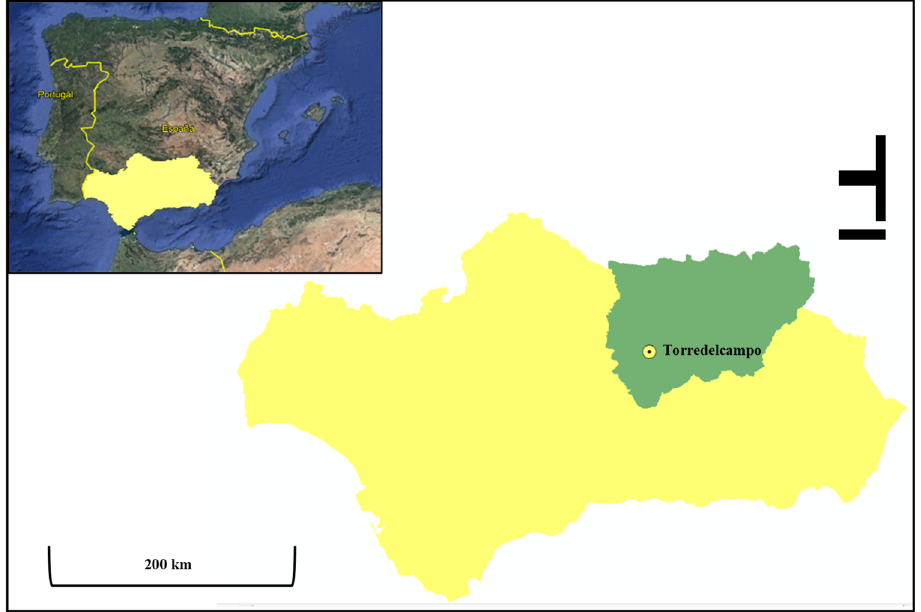
Figure 1. Location of the study area. Map of Andalusian region (yellow colour) Jaen province (green colour) and Torredelcampo municipality (point yellow and black). https://www.google.com/maps/@37.848303,-3.8662558,320m/data=!3m1!1e3 (accessed on 1 December 2021).